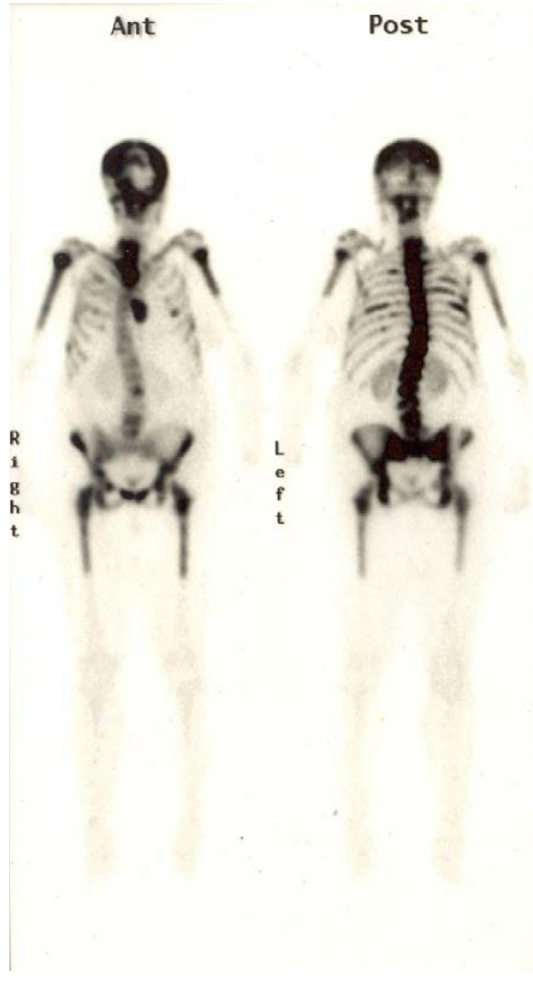
FIGURE 6. Bone scan with Tc-99m MDP showing multiple foci of increased isotope uptake throughout the axial skeleton compatible with bony metastatic